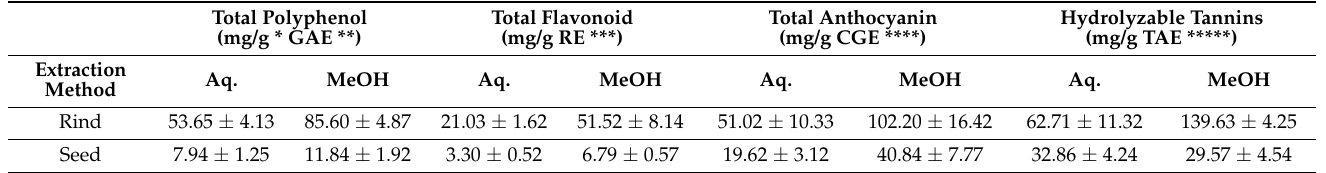
Table 2. Total polyphenol, flavonoid, anthocyanin, and hydrolyzable tannins in pomegranate rind and seed [37]. Total Polyphenol (mg/g * GAE